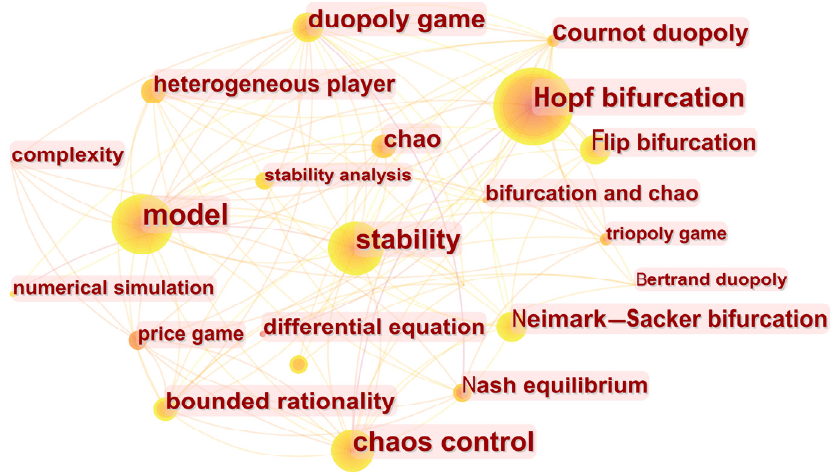
Figure 4. Hot keywords of these articles.